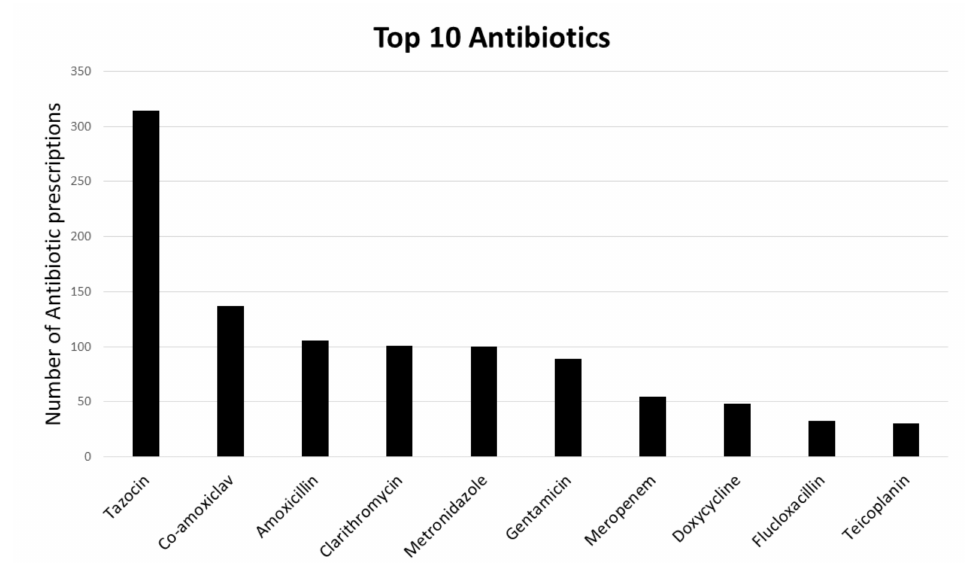
Figure 1. The most frequently prescribed antibiotics. Bars represent the number of times each antibiotic was